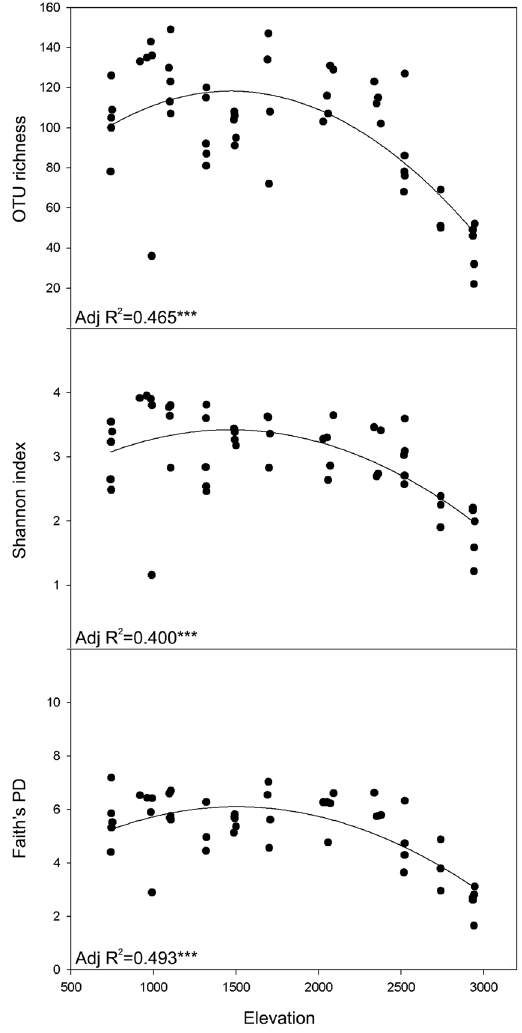
Figure 3. Soil nematode diversity measured along the elevational gradient. OTU richness, Shannon index, Faith’s PD were used. Linear, quadratic and cubic regression models were fitted to assess the relationship of elevation with diversity indices of the nematode communities. Model selection was carried out based on adjusted R 2 and root mean square error. Only the best fit quadratic regression was shown. Significance levels were less than 0.001, shown as *** . Adj R 2 is coefficient of